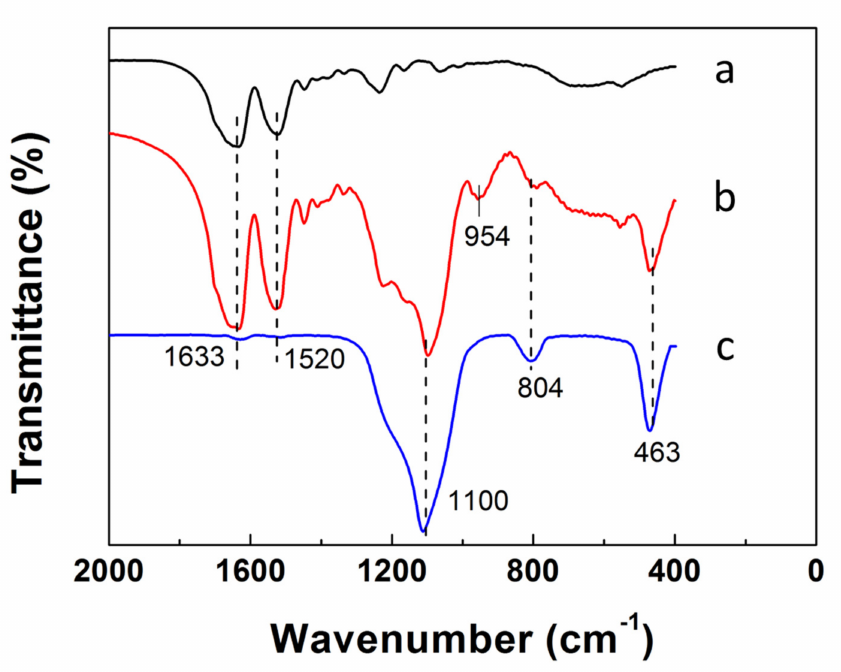
Figure 4. FTIR spectra of ( a ) SF fiber templates, ( b ) SF@silica NFs, ( c ) mesoporous silica nanotubes